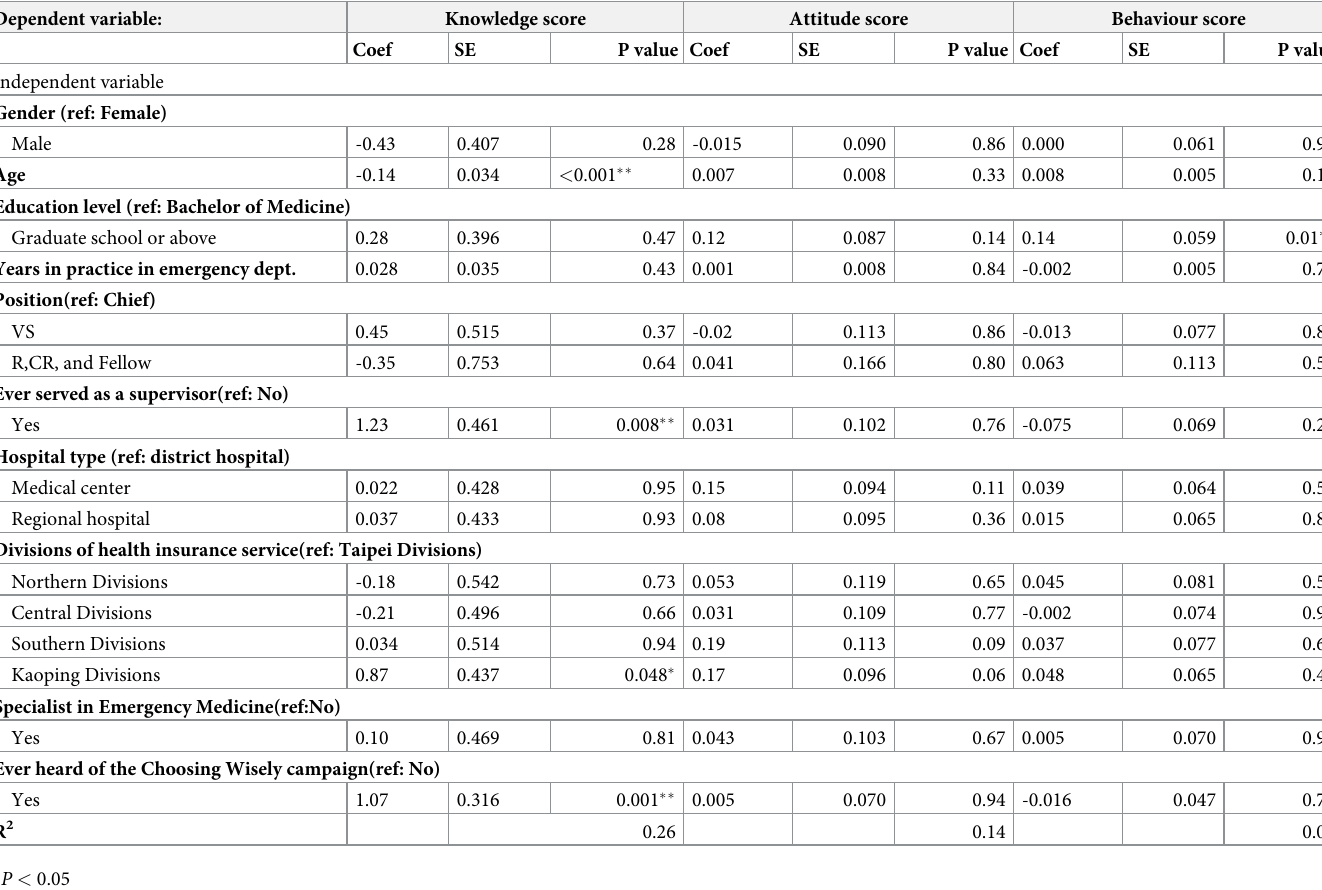
error, a population frequency of 10%, and population size of 2142. A minimum required sam- ple size of 130 participants was calculated [19]. Therefore, our study sample size is valid for the study. Most of the samples were collected from physicians working in medical centres and working in the southern region. Therefore, the results were possibly affected by respondents being from different levels of hospitals and health insurance districts. Because the survey Table 4. Predictors of emergency physicians’ scores on KAB of Choosing